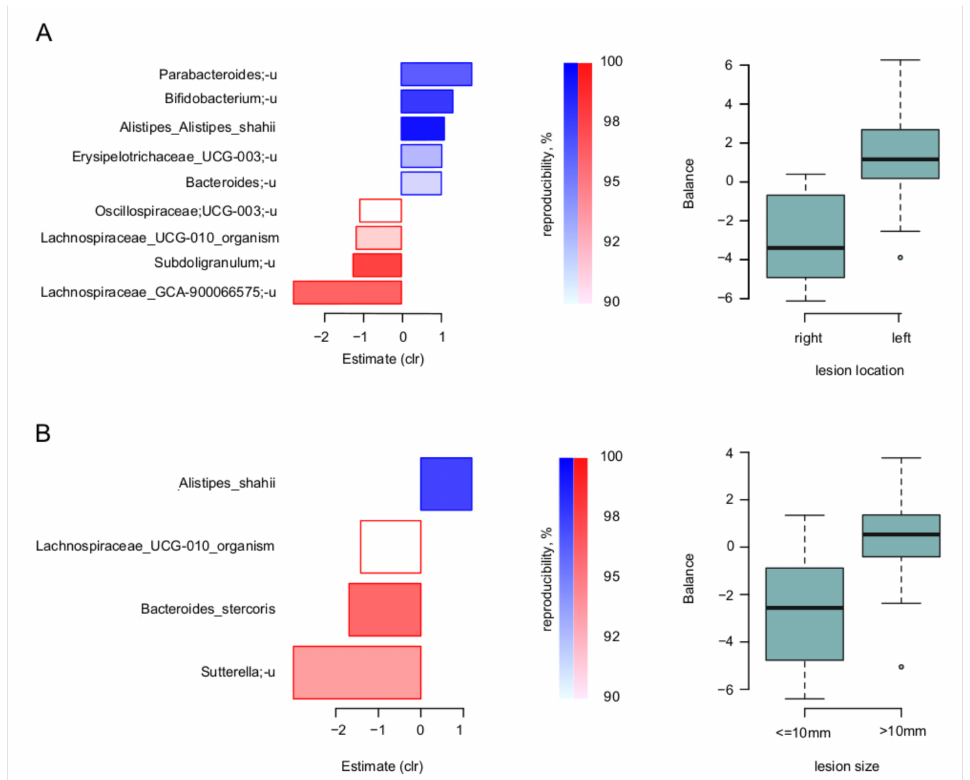
Figure 3. Link of lesion parameters to tumor-associated microbiome: results of “nearest balance” method for the biopsy samples. On the left: bacterial species—reproducible members of the nearest balances revealed in cross validation. The upper blueish bars show the taxa in the numerator in the order of decreasing linear regression coefficient between clr-transformed microbial abundance and factor ( x axis). The lower reddish bars show denominator taxa. The color tint is proportional to the reproducibility of the taxa in cross-validation analysis (the proportion of iterations in which the taxon was included in the nearest balance). On the right: distribution of the balance values for each parameter value. ( A ) Location of lesion. ( B ) Size of